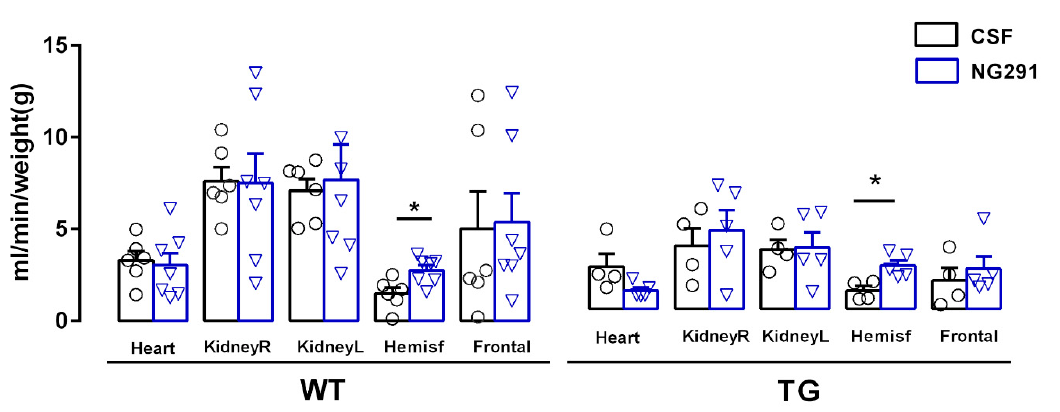
Figure 3. Stimulation of B2R improves cerebral blood flow in WT and TG animals. Blood flow was evaluated in different organs of WT and TG animals treated or not with B2R agonist NG291. Data were analyzed with Student’s t -test. * p < 0.05.